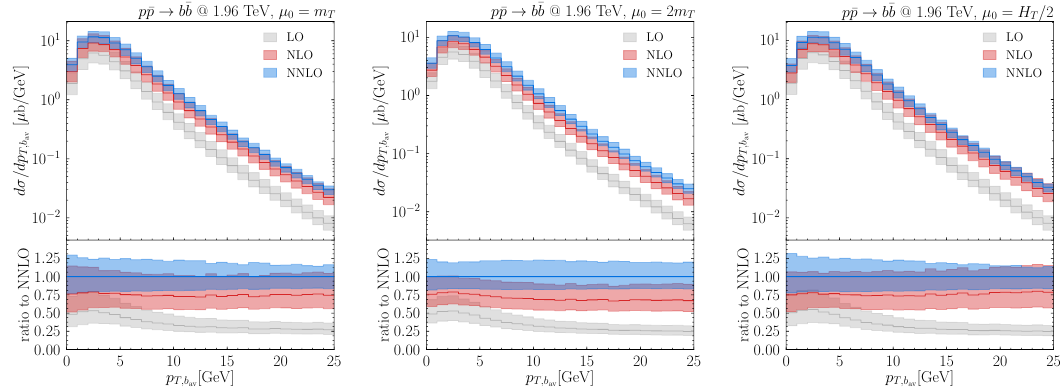
Figure 2 . Transverse momentum distributions at the Tevatron, for the scale choice (cid:22) 0 = m T (left), (cid:22) 0 = 2 m T (central) and (cid:22) 0 = H T = 2 (right). The lower panels show the ratio to the NNLO